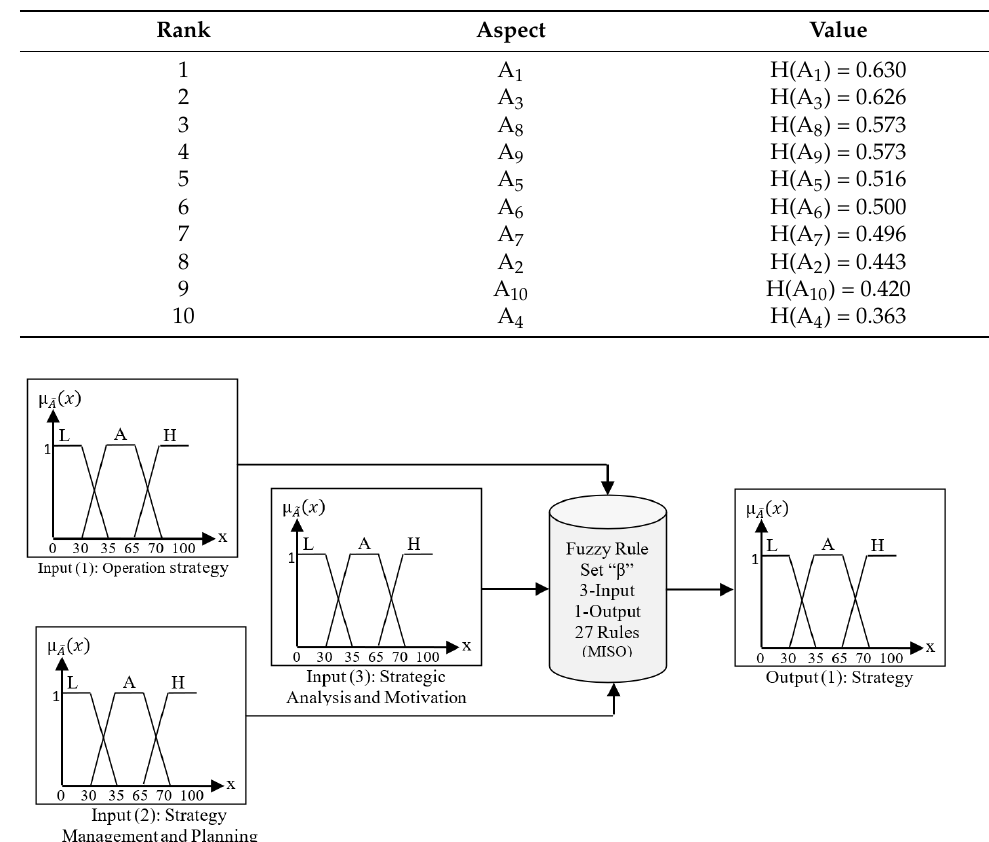
Table 9. Ranking of fuzzy aspects based on the α -cut set.